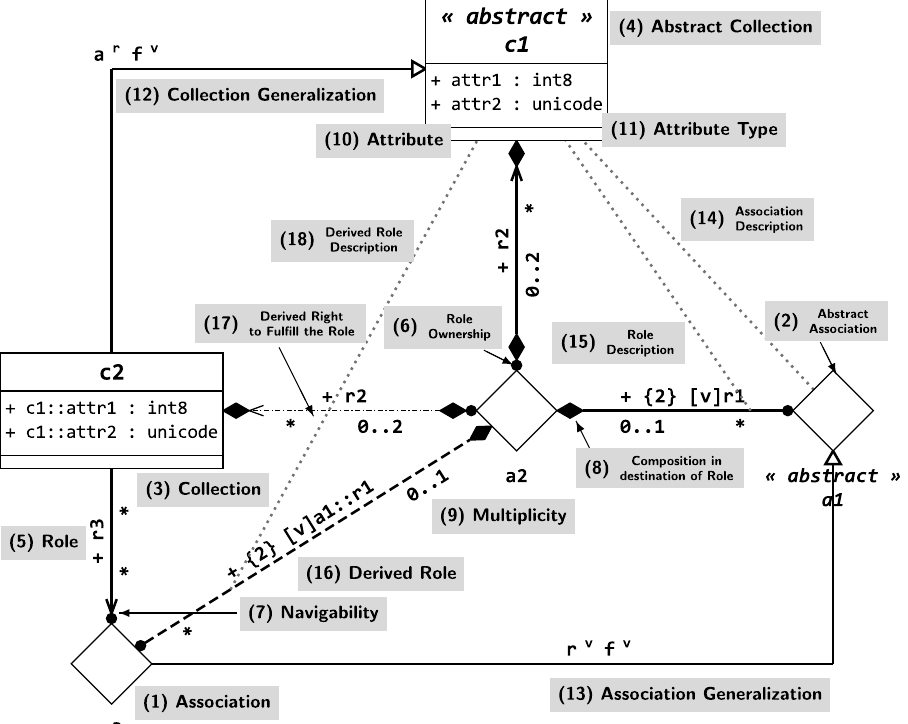
Fig. 5. Sample database schema diagram in